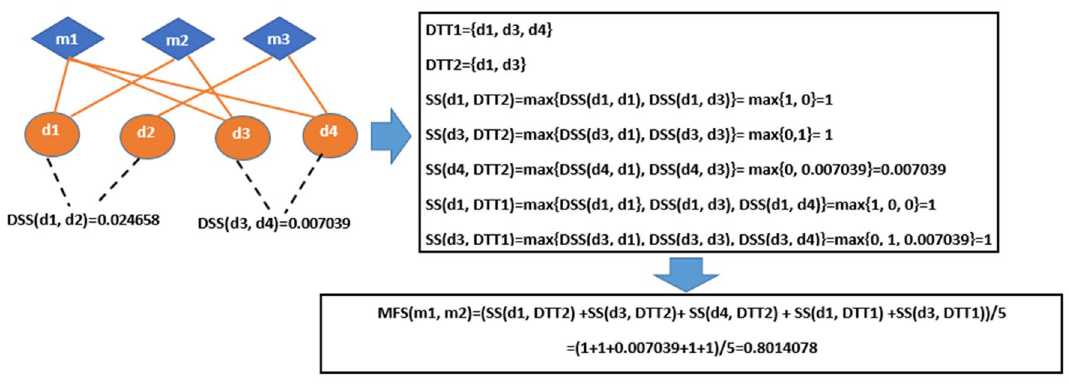
Figure 2. Illustration of calculating miRNA functional